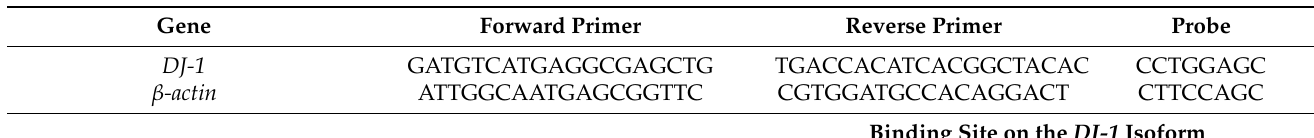
Table 1. Primer and probe sequences used for RT-qPCR assays; the target sequence and binding site on two DJ-1 isoforms of four shDJ-1 plasmids used in the